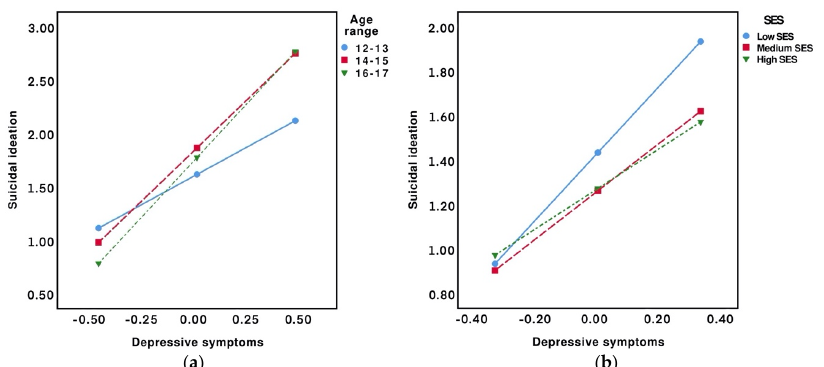
Figure 1. ( a ) Plot diagram for the conditional effects of depressive symptoms ( − 1 SD, mean, +1 SD) on suicidal ideation for the values of age range in the referred sample; ( b ) Plot diagram for the conditional effects of depressive symptoms ( − 1 SD, mean, +1 SD) on suicidal ideation for the values of socioeconomic status (SES) in the non-referred sample.